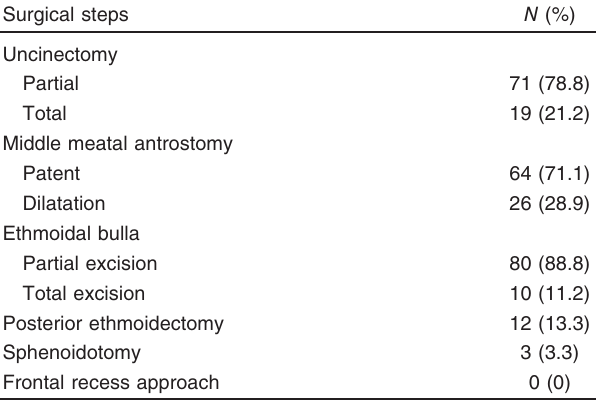
Table 3 Surgical intervention